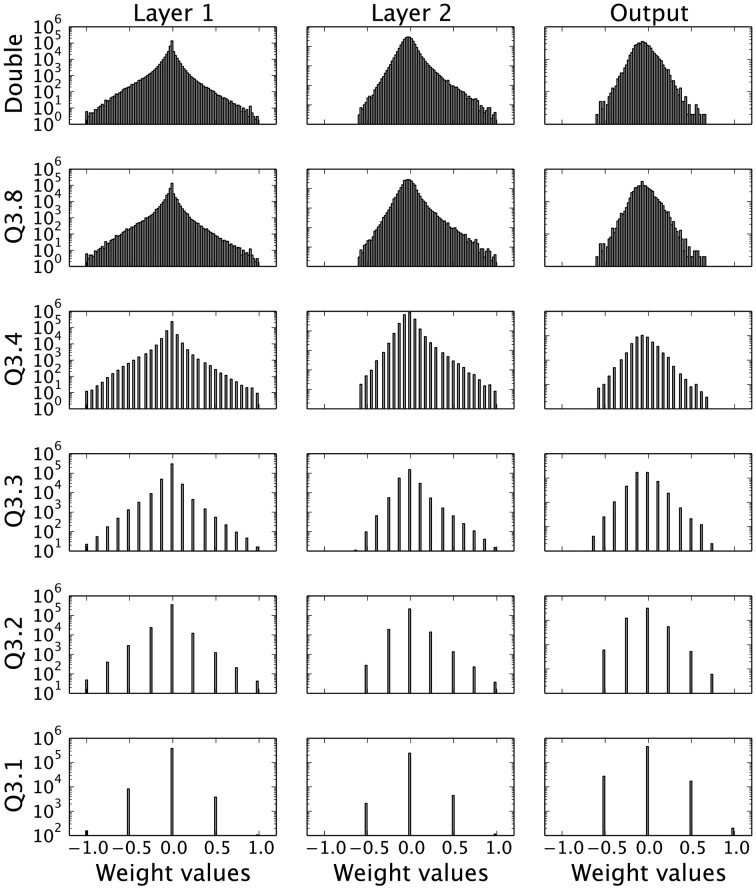
Weight distributions for different bit precision levels and DBN layers. Each row represents different fixed-point weight precisions, while each column represents a layer of the DBN, starting from Layer 1 (left), Layer 2 (middle) to the Output Layer (right). Despite the different discretization levels, the overall shape of the weight distribution is conserved.